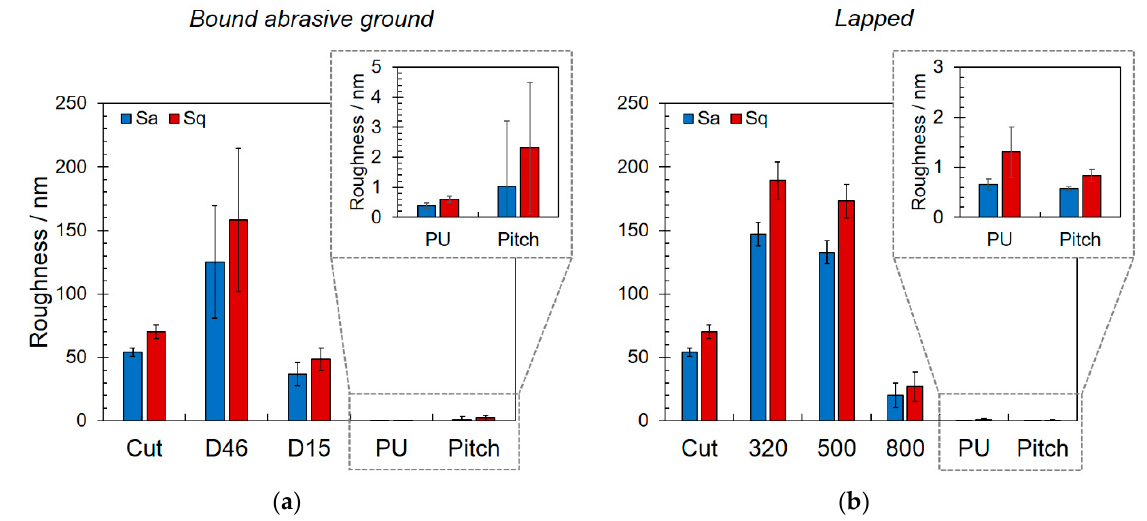
Figure 3. Average area roughness Sa and root mean square area roughness after each manufacturing step for bound abrasive ground ( a ) and lapped ( b ) samples. For explanation of the particular sample designations given in the x-axis, see Figure 1.